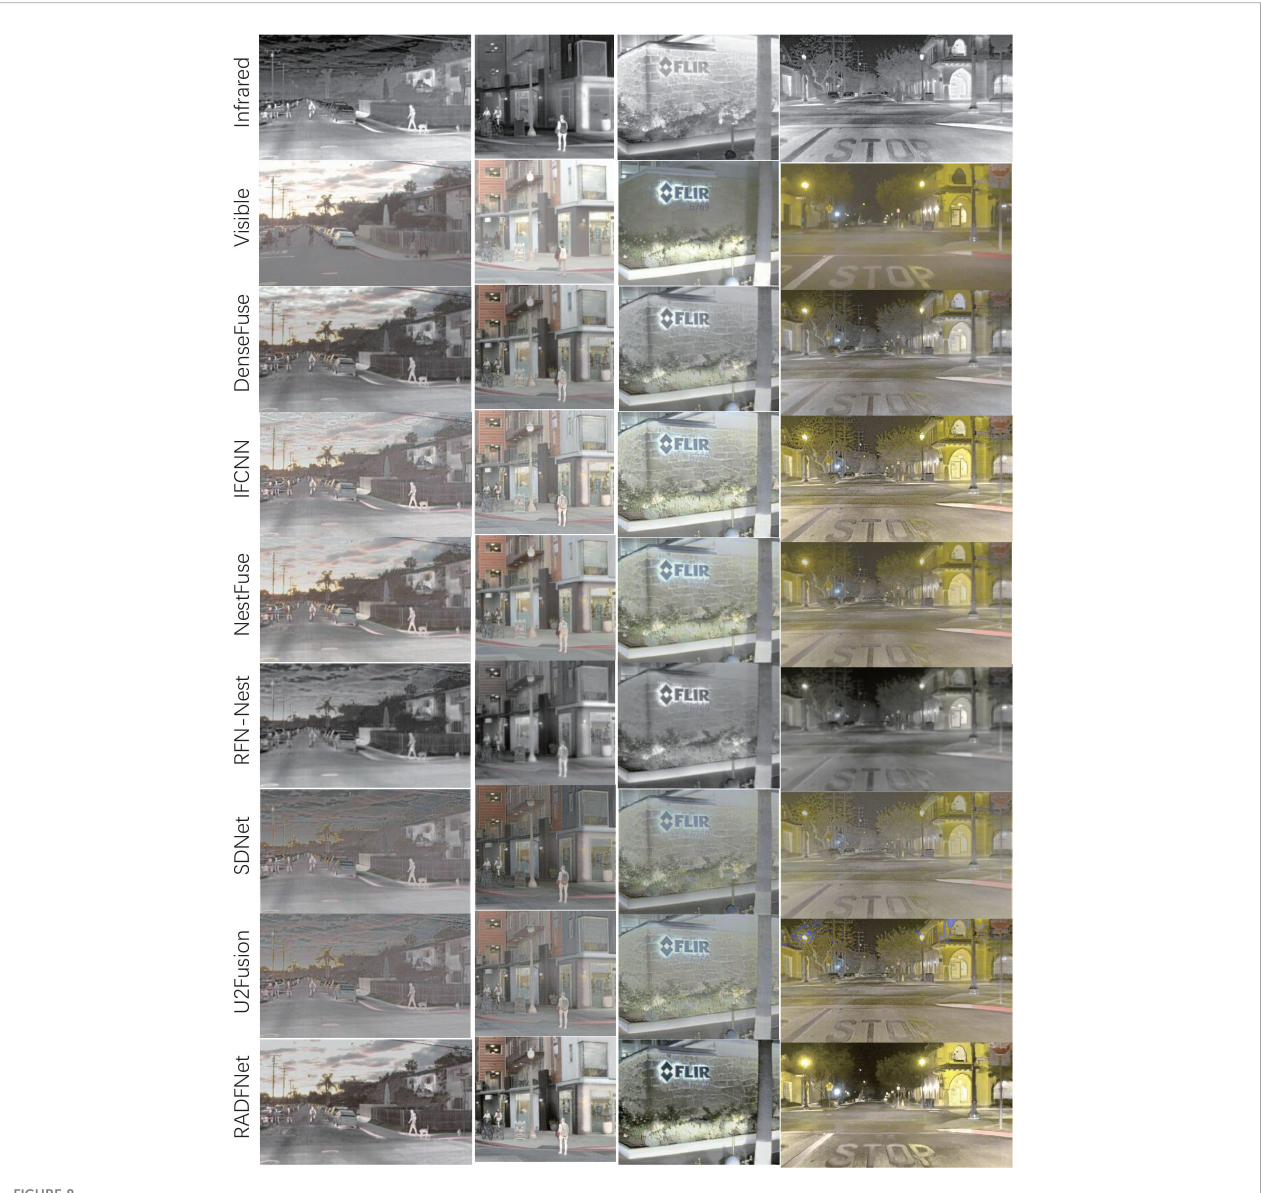
FIGURE 8 The visual results comparison with different methods on the Roadscene